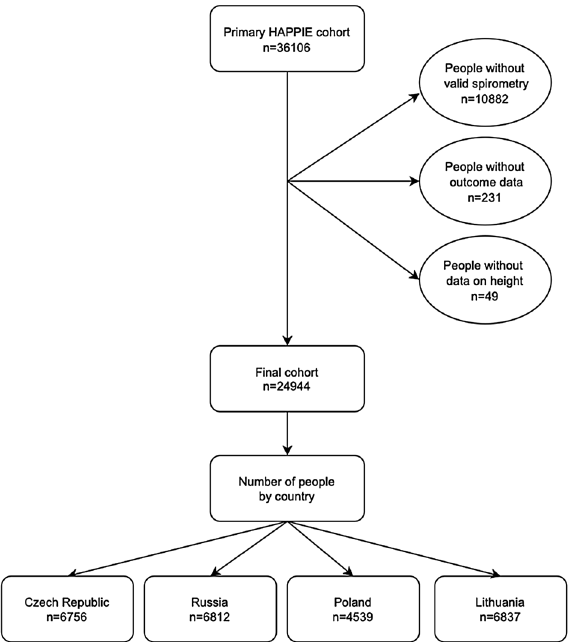
Figure 1. Flowchart of exclusion criteria of the HAPIEE study